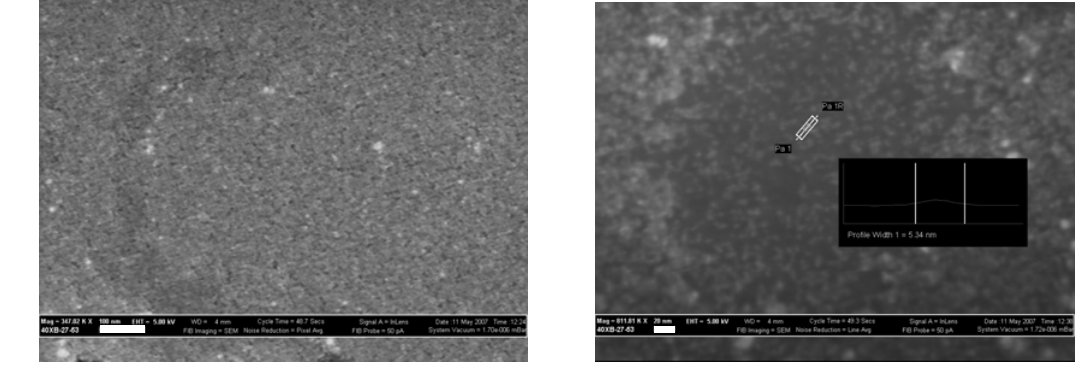
Figure 7 . Left: overview of the annealed SnO marker is 100 nm). Right: a higher magnification zone of the film (the white marker is 20